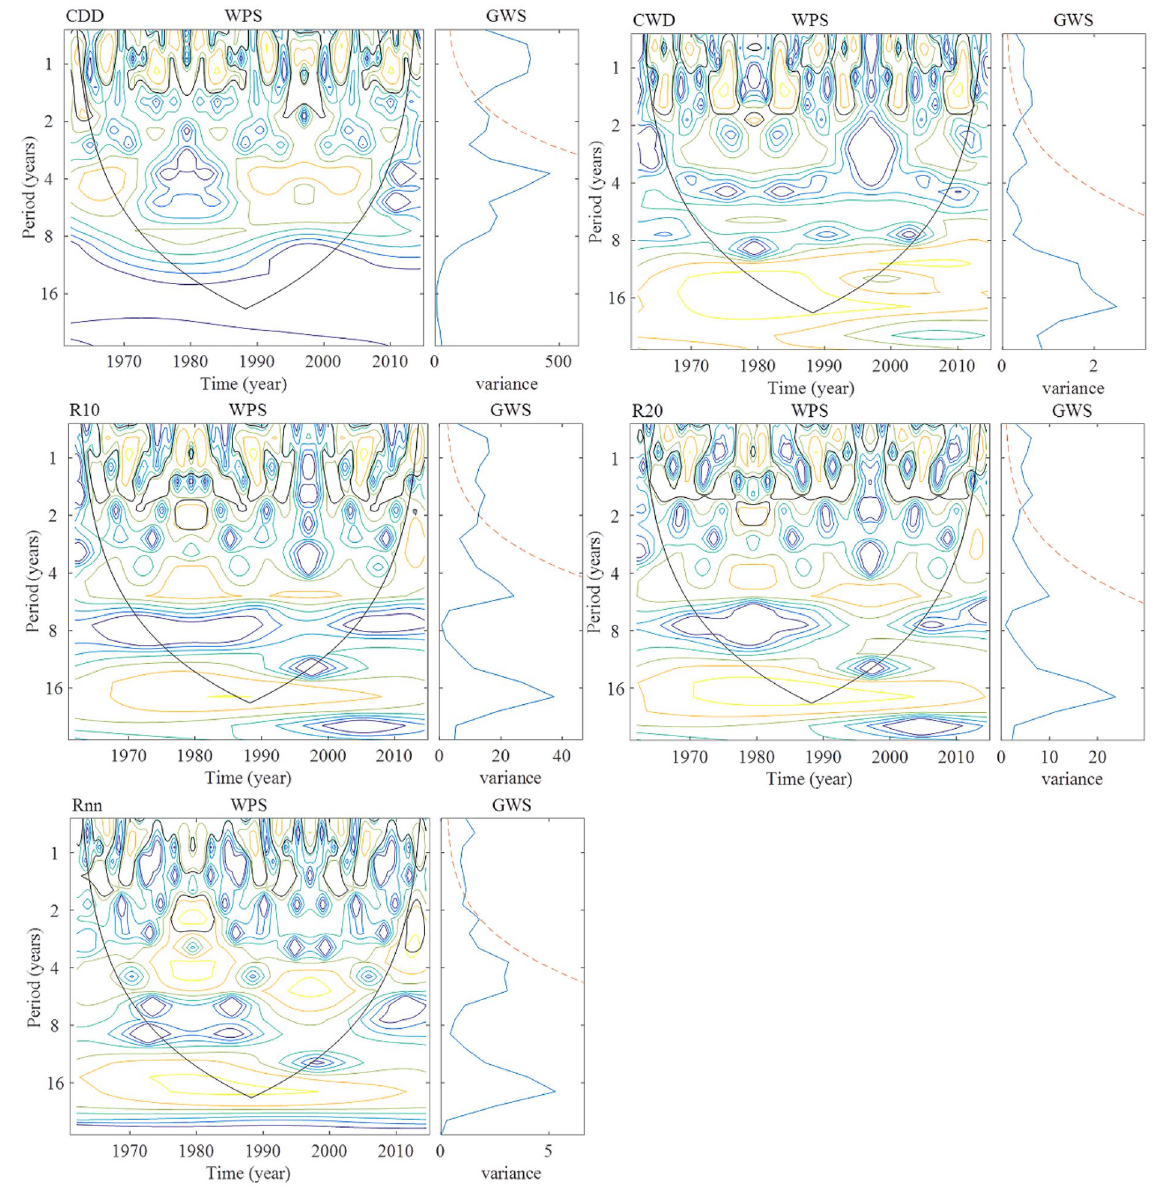
Figure 9. Wavelet power and global wavelet spectra for the time series of the indices related to the number of precipitation days in Shandong from 1961 to 2015 (The range surrounded by the black outline in WPS refers to passing 95% of the significance level, the red dashed line in GWS is the 95% confidence spectrum ).